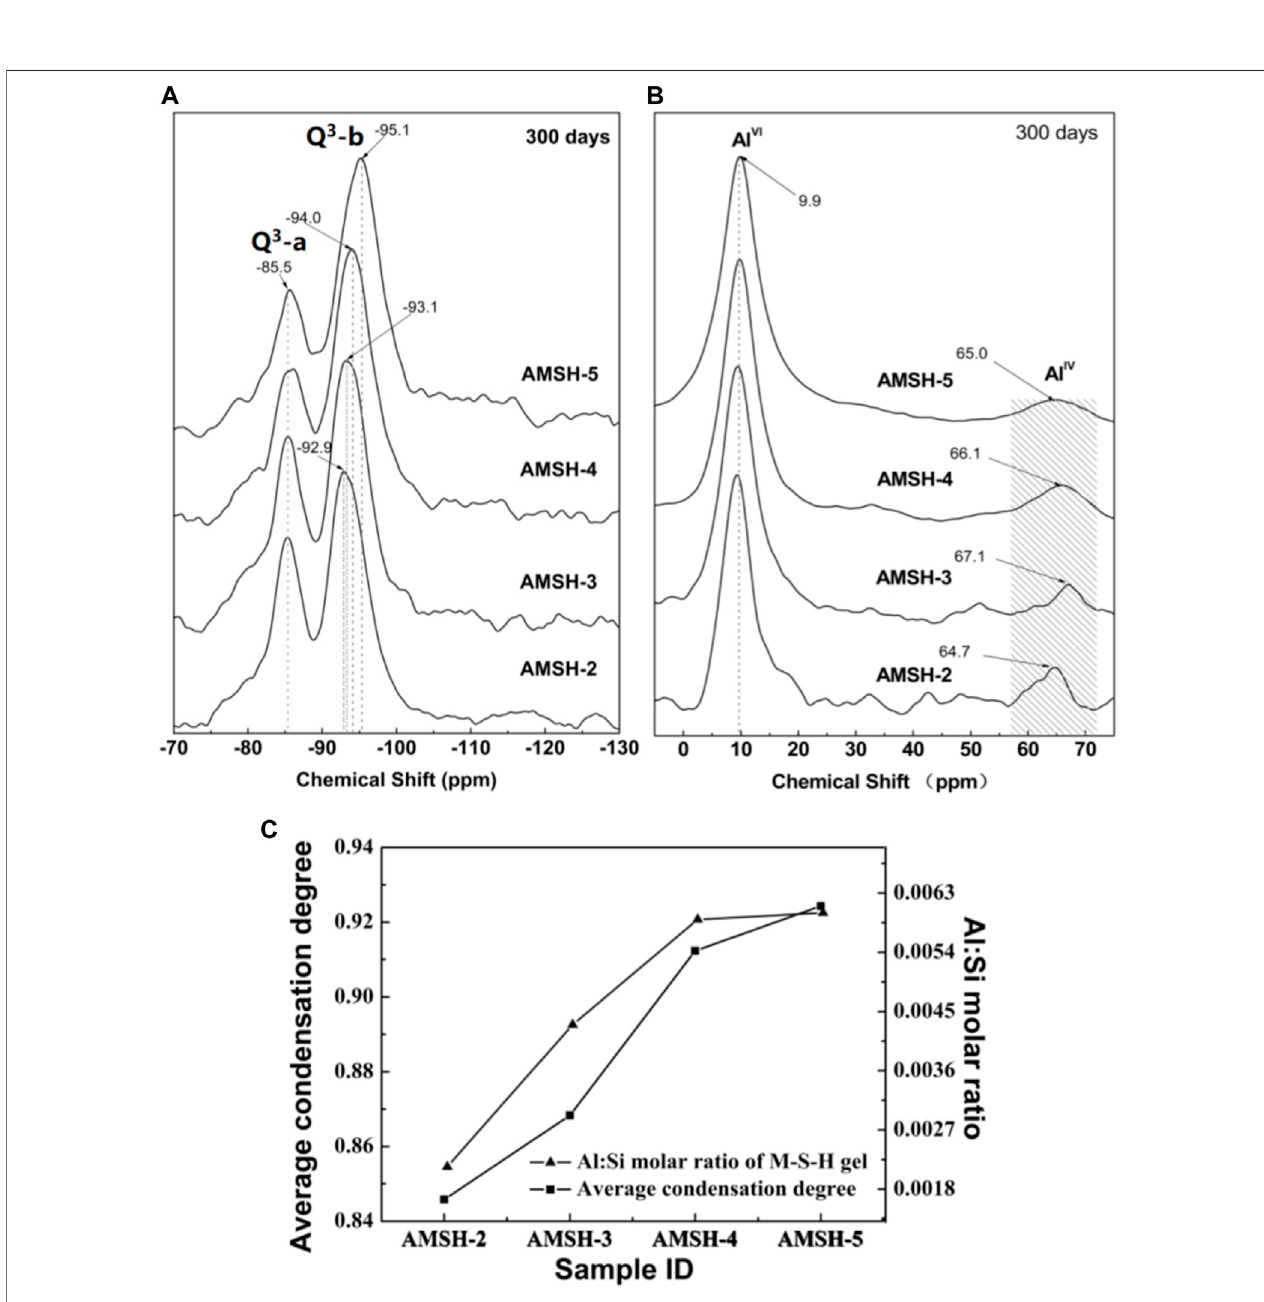
FIGURE 3 | 29 Si NMR chemical shifts of MSH samples with different Al 3+ contents after curing for 300 days (A) silica (B) aluminum (C) changes of the average condensation degree.